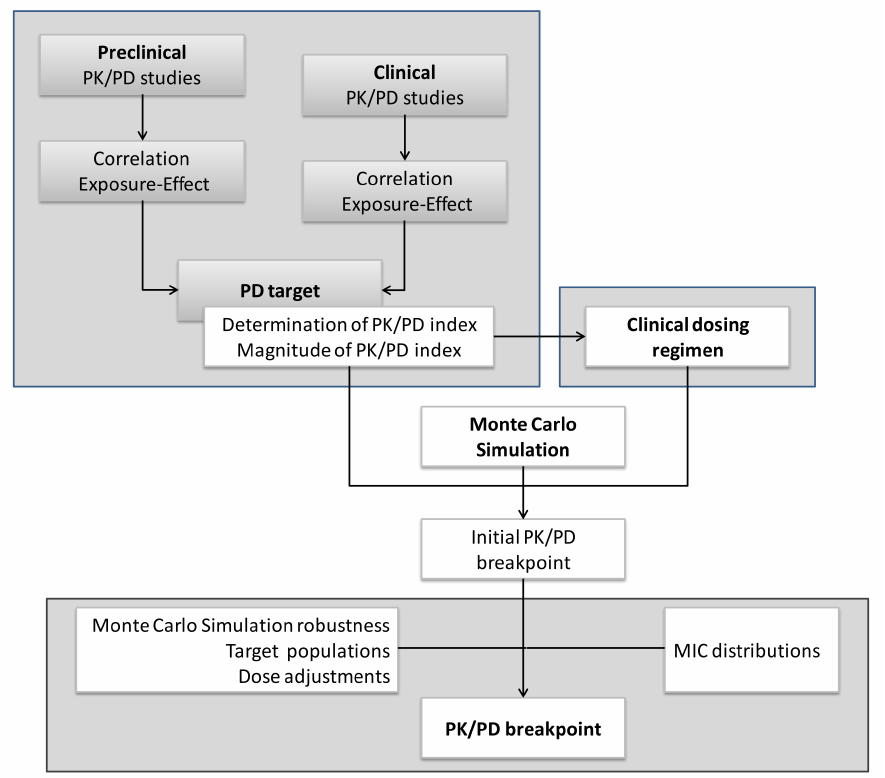
Figure 7. Process of setting PK/PD breakpoints by EUCAST. Adapted with permission from [60]; Published by Elsevier,